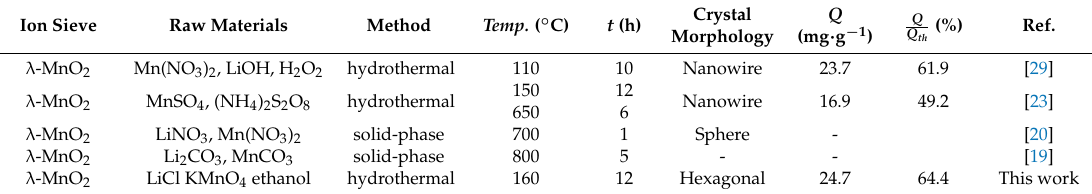
Figure 9. Fitting result of adsorption data by Crank model using 50 mg·L − 1 Li + on 0.1 g HMO at 18 °C. Table 3. Similar method of adsorption capacity comparison.